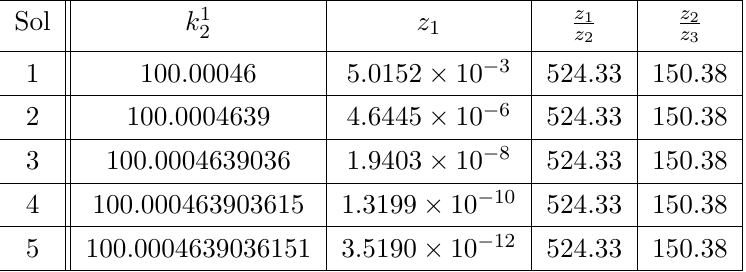
Table 1 . Scaling process of the four Gibbons-Hawking centers